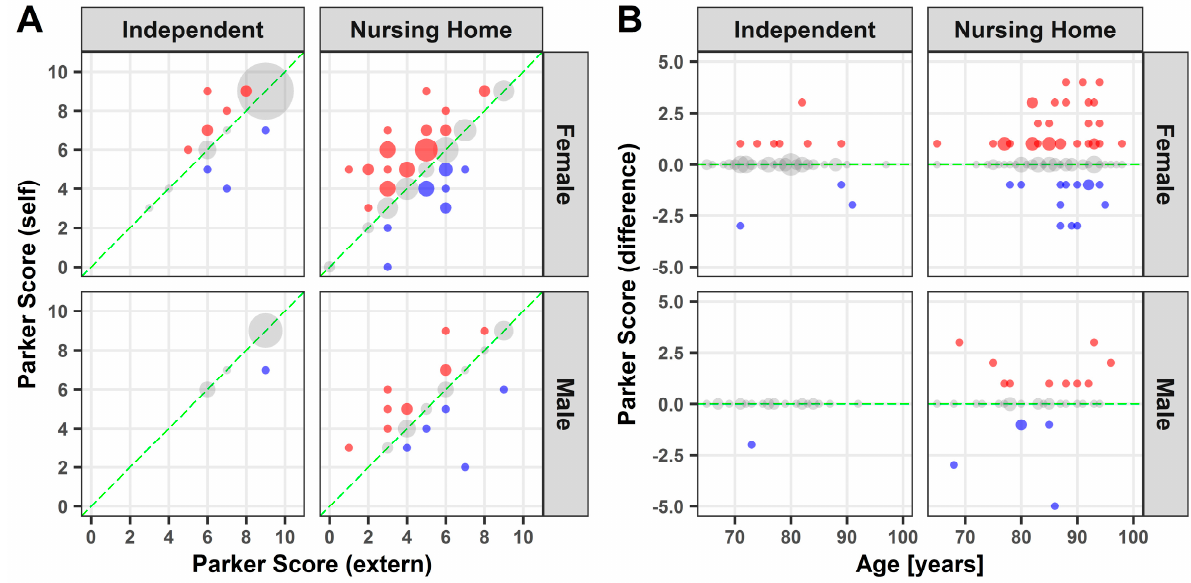
Figure 1. Parker Mobility Score: Point plot illustration of self and external assessment of the Parker Mobility Score ( A ) as well as the difference against age ( B ). Grey dots: no difference; blue dots: underestimation; red dots: overestimation. Dot size represents the relative number of participants.